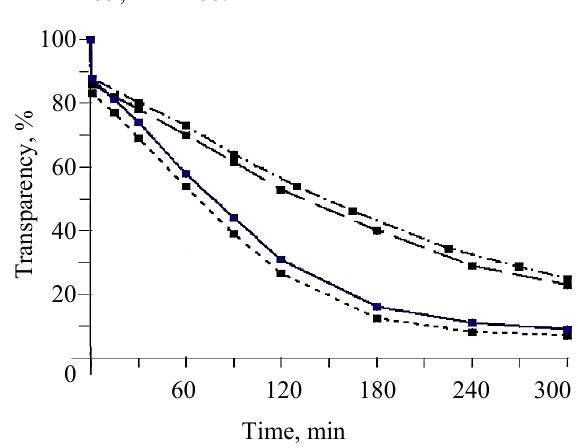
Fig. 5. Change in the transparency of solutions: at Δ C = 40 g/100 g of water and a temperature, °С: __ , __ 70. ___ ___ 55; at Δ C = 60 g/100 g of water and a temperature, °С: _____ 70 , – - –